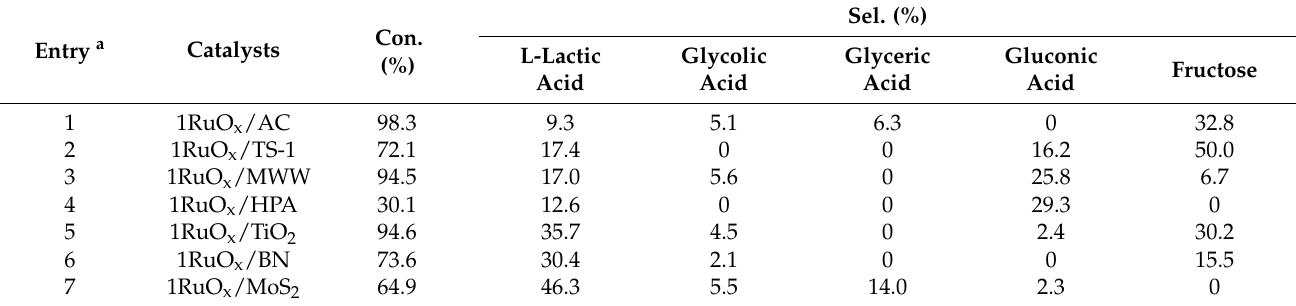
Table 1. Product distribution for glucose conversion via different Ru-based